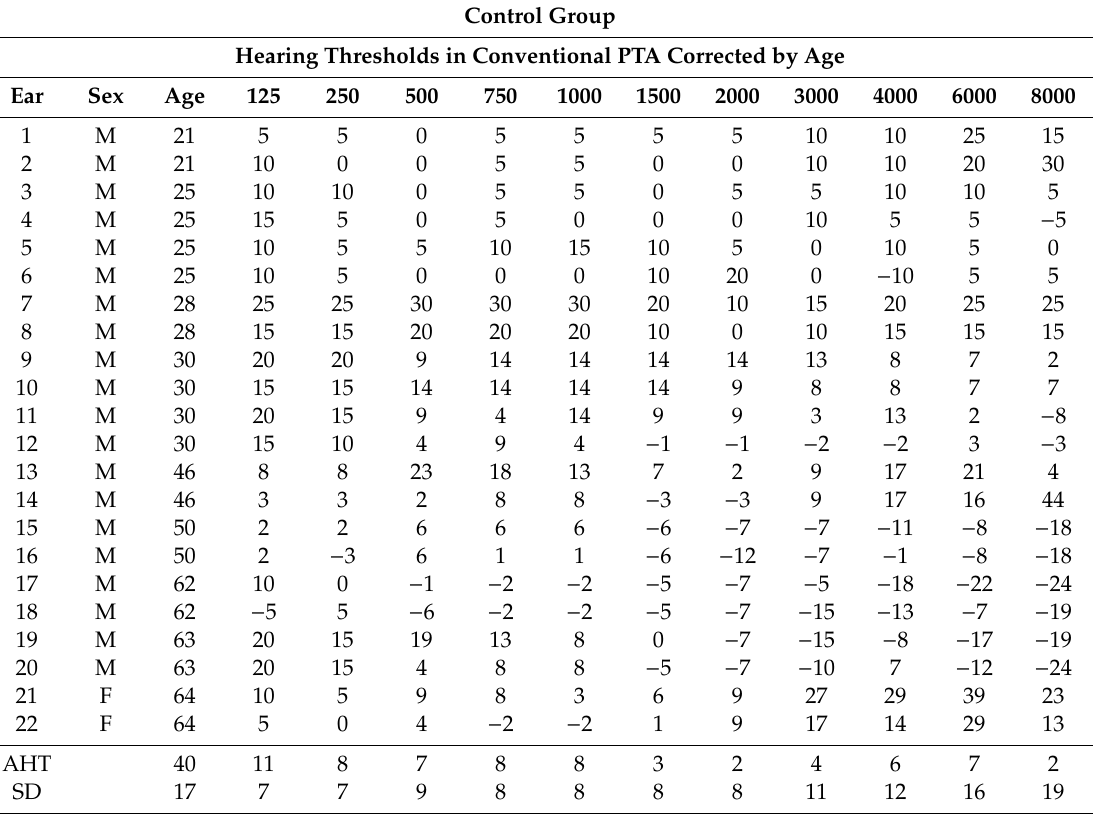
Table 9. Hearing thresholds of the control group with values corrected by age. Control